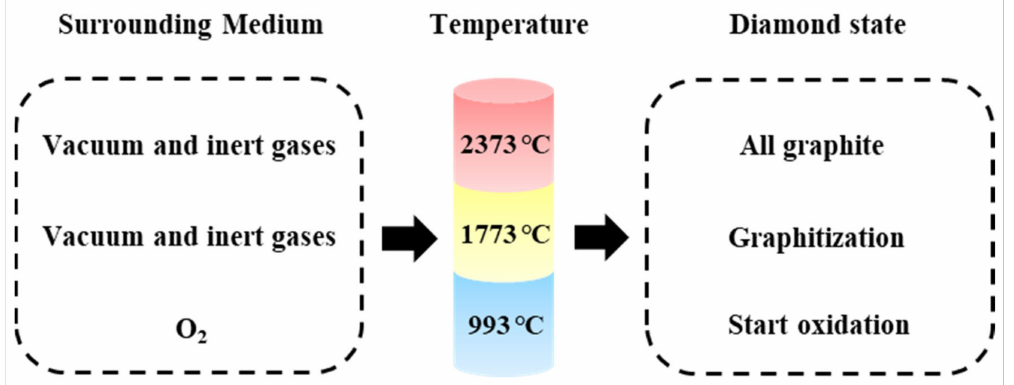
Figure 3. The temperature dependence on state change of diamond during heating in different mediums [28].